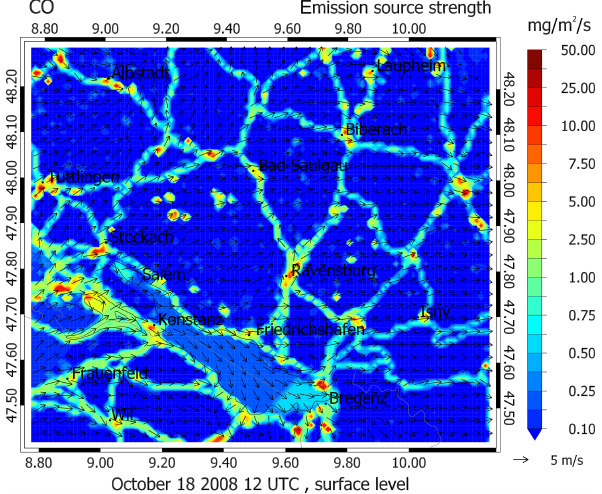
Figure 1. CO emission source strength (mgm − 2 s − 1 ) at the surface level of the ZPS grid for 18 October 2008, 12:00UTC. Black arrows indicate the direction and strength of surface